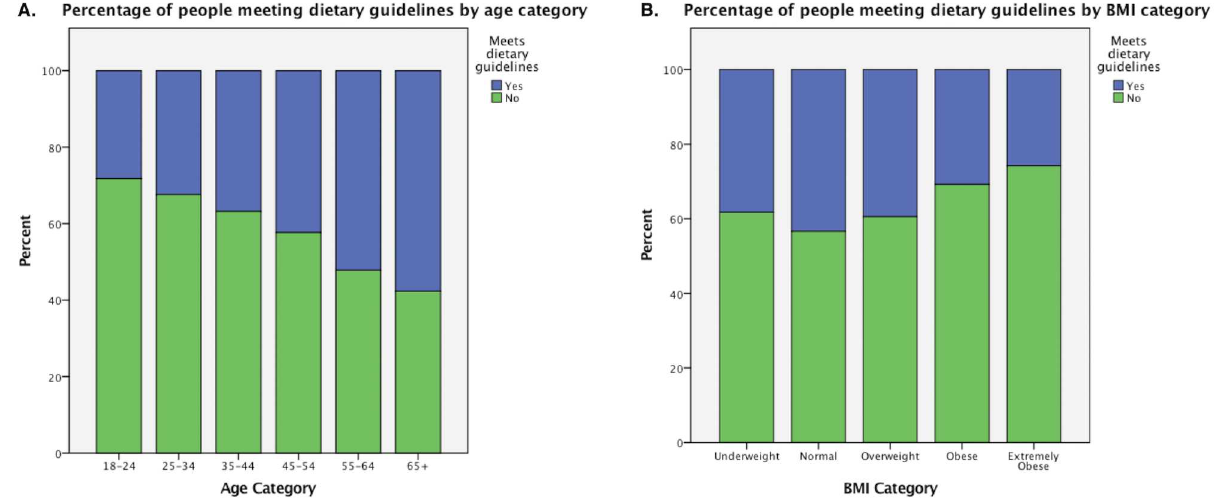
Fig 5. Percentage of people meeting dietary recommendations by age and BMI category.